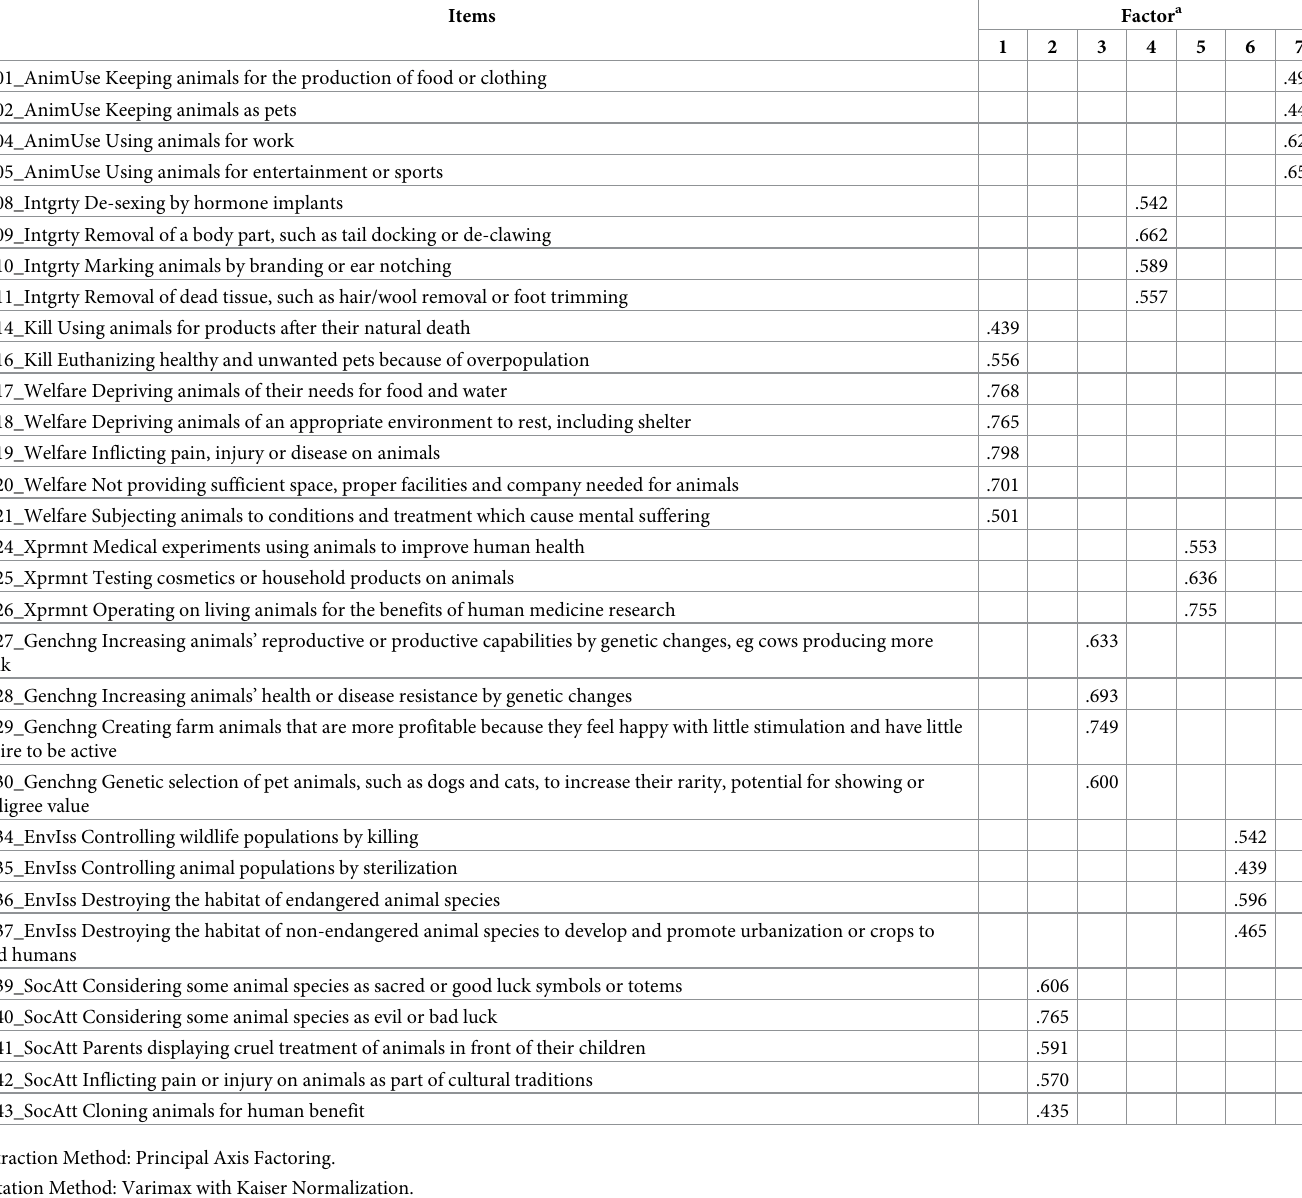
Table 1. AIS rotated factor